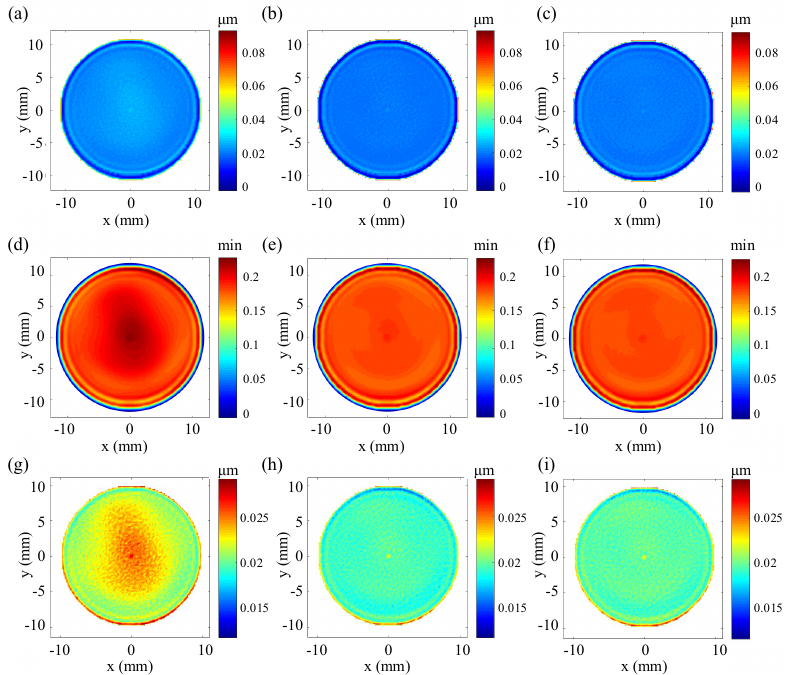
Figure 14. Residual error corresponding to: ( a ) the unoptimized path; ( b ) the RMS-map-based optimized path; and ( c ) the PV-map-based optimized path. Dwell time map along: ( d ) the unoptimized path; ( e ) the RMS-map-based optimized path; and ( f ) the PV-map-based optimized path. Residual error of the concerned surface region polishing along: ( g ) the unoptimized path; ( h ) the RMS-map-based optimized path; and the ( i ) PV-map-based optimized path.